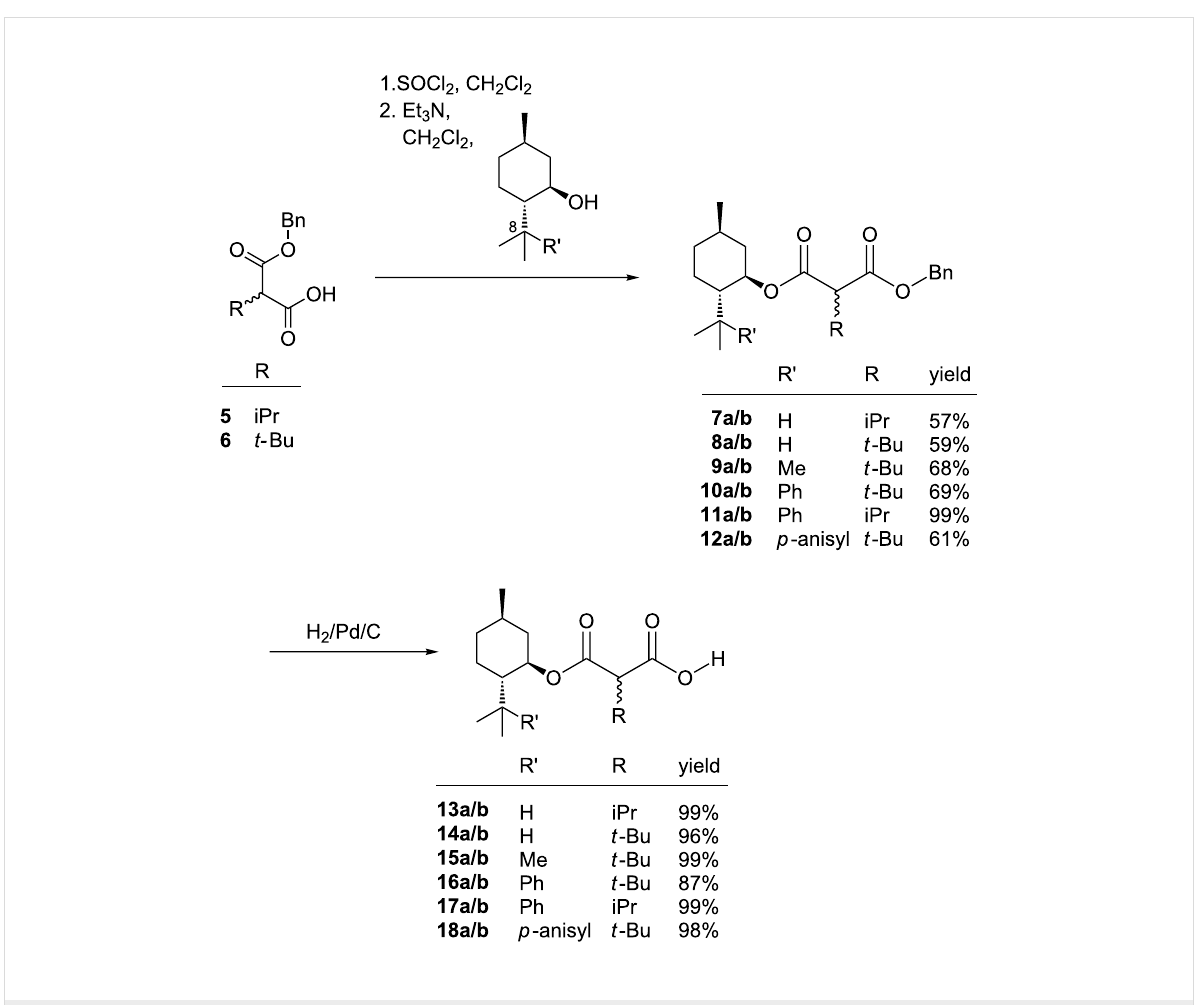
Scheme 1: Synthesis of carboxylic acids 13a/b – 18a/b .